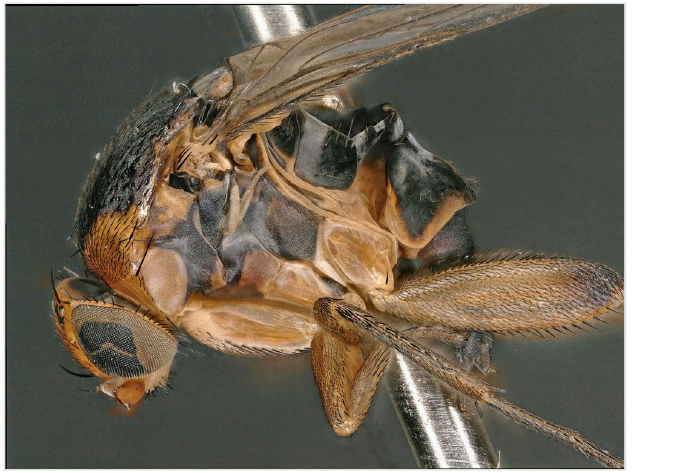
Figure 1. Habitus, left lateral, of Melaloncha ( Melaloncha ) peacockorum , new species